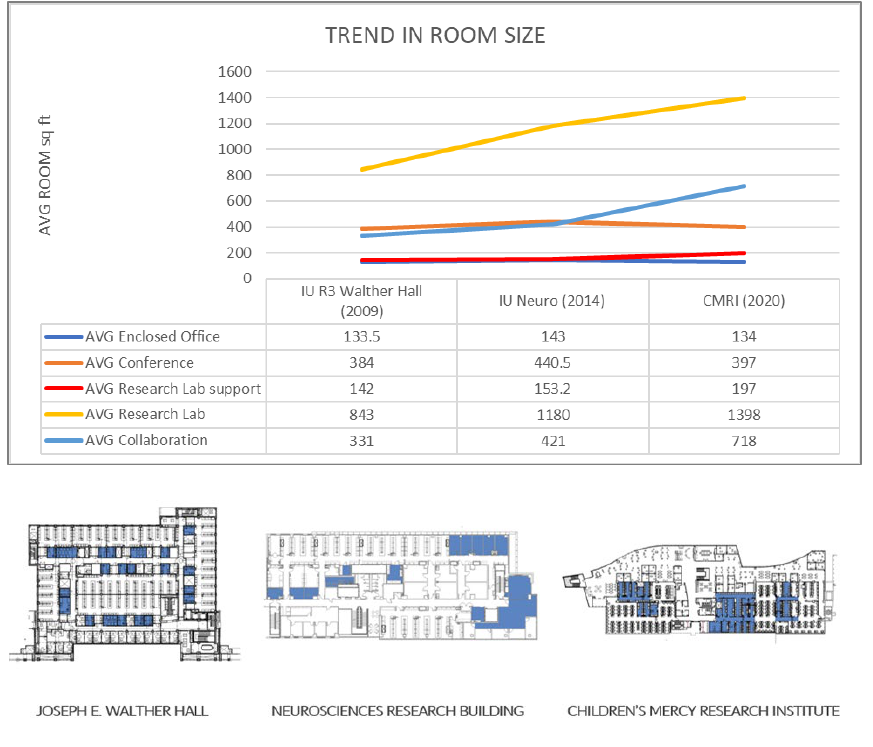
Figure 6 The trend in laboratory and workplace square footage.